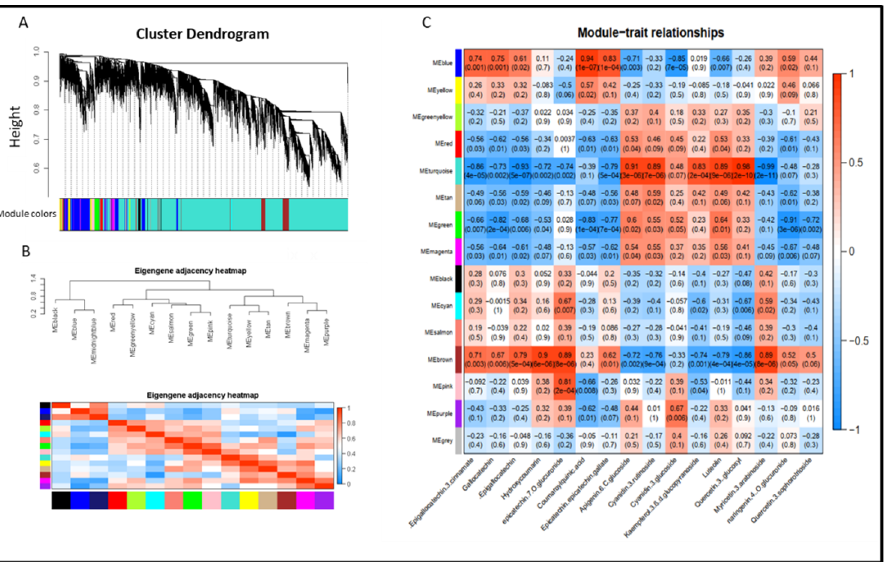
Figure 4. Gene modules ( A ) identified by weighted gene co-expression network analysis (WGCNA). Relationships of consensus module genes ( B ) and content of catechins and flavonols ( C ). The module name is shown on the left side of each cell. Numbers in the table report the correlations of the corresponding module eigengenes and contents, with the p values printed below the correlations in parentheses. The table is color coded by correlation according to the color legend. Intensity and direction of correlations are indicated on the right side of the heatmap (red, positively correlated; blue, negatively correlated).